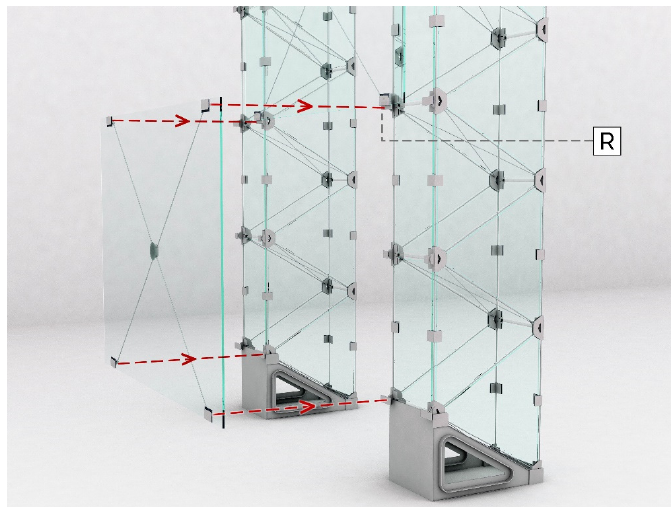
Figure 7. Hybrid longitudinal wall bracing system: R—point fixing of the panel corners to the TVT γ -bis nodes by means of pole-and-plate devices. Buildings 2017 , 7 , 50